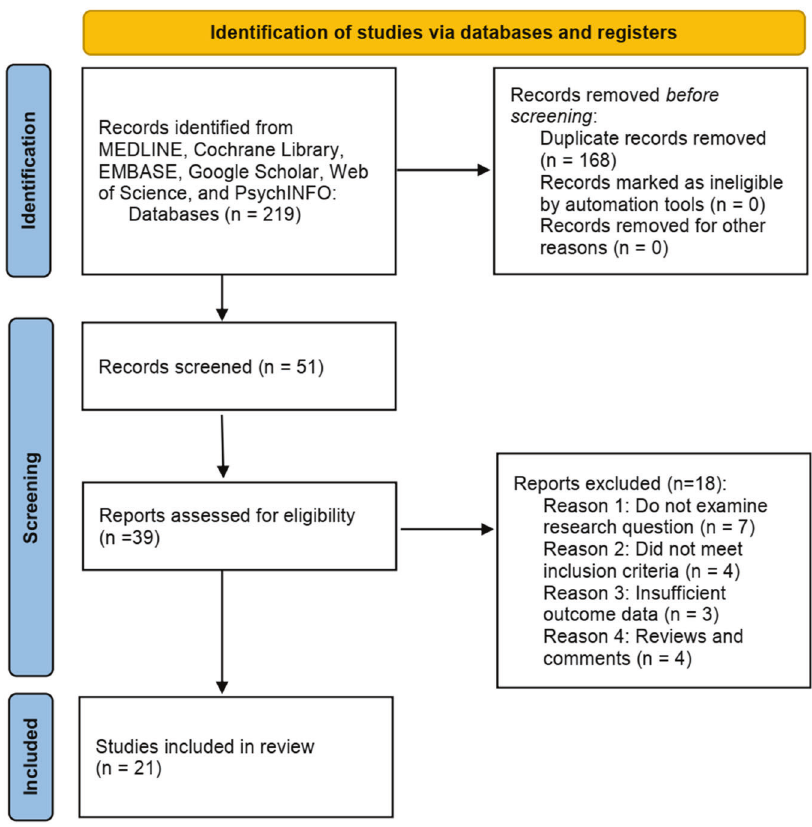
Fig. 1 The search fl owchart for identifying the eligible studies. Six common-used databases were applied to identify the eligible studies. Finally, 21 studies were included for further reviewing and